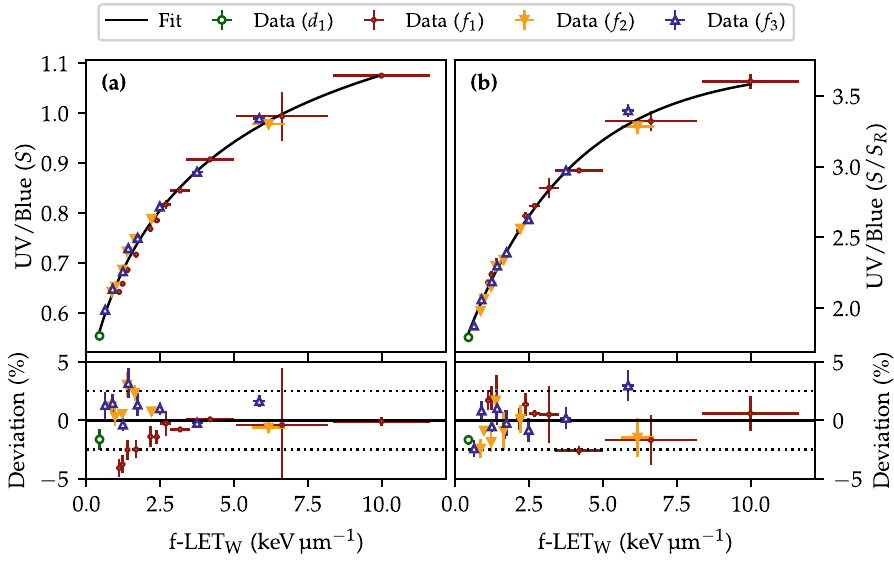
text. The legend refers to the fields defined in Table 1.